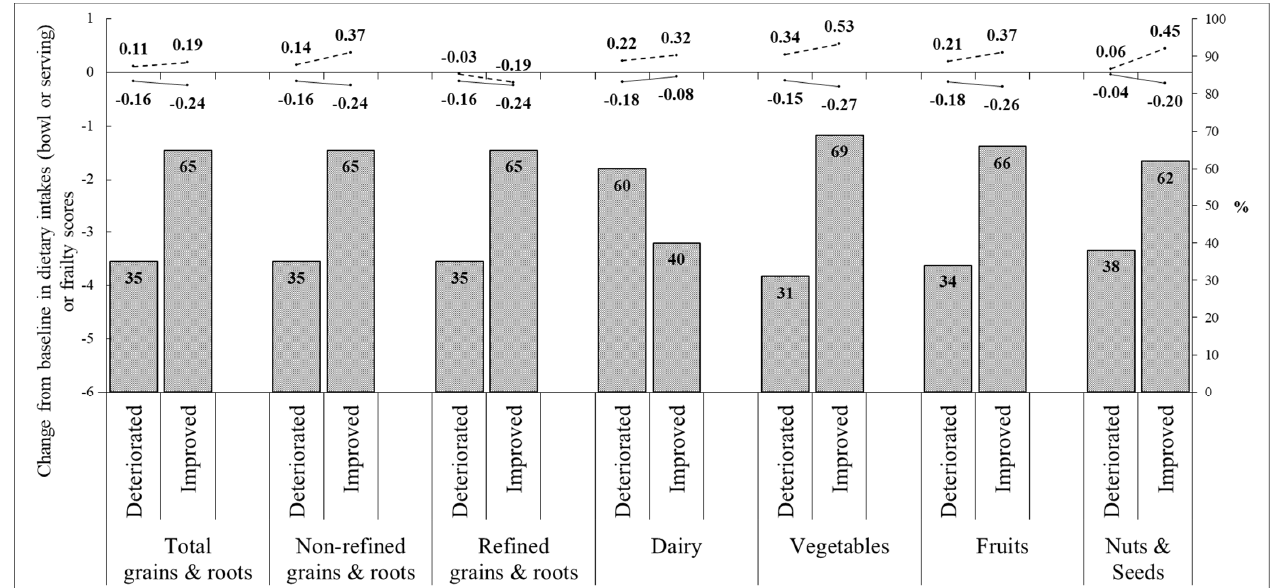
Figure 3. Effects of nutrition program on changes of dietary behavioral stages, dietary intakes, and frailty scores. The grey bars at the bottom represent “the improved or maintained at advanced stages” subgroup and “the deteriorated or maintained at early stages” subgroup, classified by the status of nutrition group participants’ shift in each healthy dietary behavioral stage at post-intervention. According to the two subgroups for each healthy dietary behavior, the changes from baseline in dietary intakes ( ··· ) and frailty scores ( ― ) are shown in lines at the top of the figure.